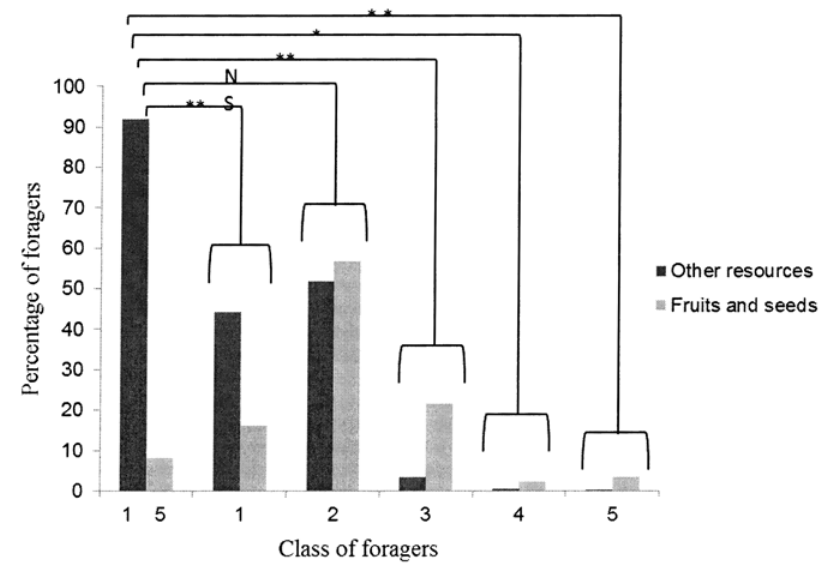
Fig. 3. Percentage of foragers of Atta robusta that transported fruits and seeds compared with that transporting other resources. NS = no significant difference by test χ2, * significant difference, p ≤ 0.0197 and ** significant difference, p <0.0001. Class 1 (χ2 = 21.13 and p <0.0001), class 2 (χ2 = 0.39 and p = 0.53), class 3 (χ2 = 75.13 and p <0.0001), class 4 (χ2 = 5.44 and p <0.0197) and class 5 (χ2 = 44.78 and p